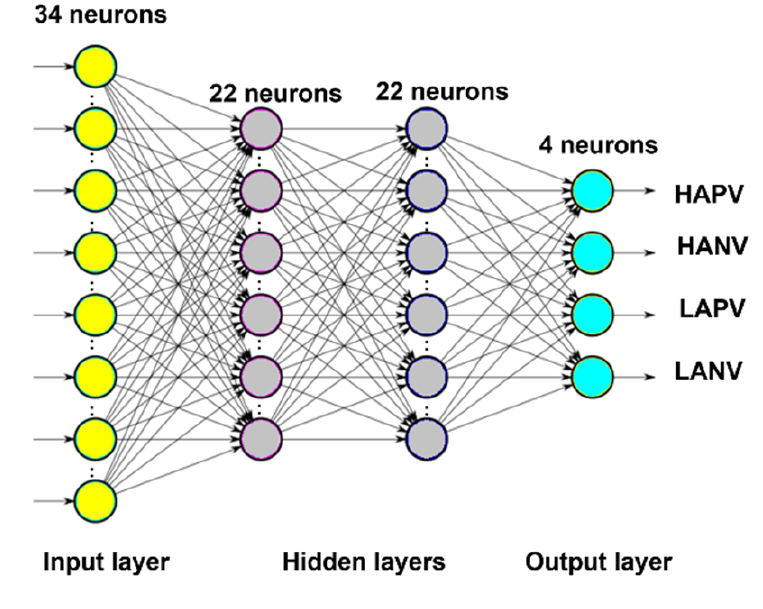
Figure 4. First Feed Forward Neural Network architecture.